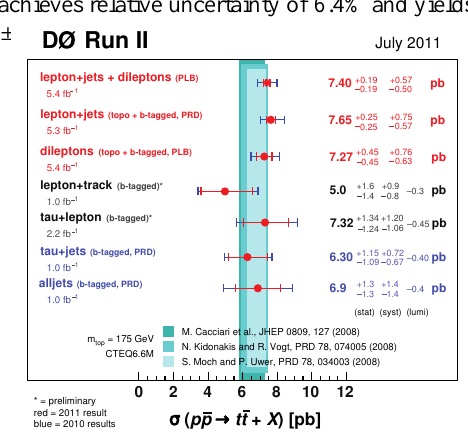
Fig. 4. Summary of the σ t ¯ t measurements by the D0 experiment.